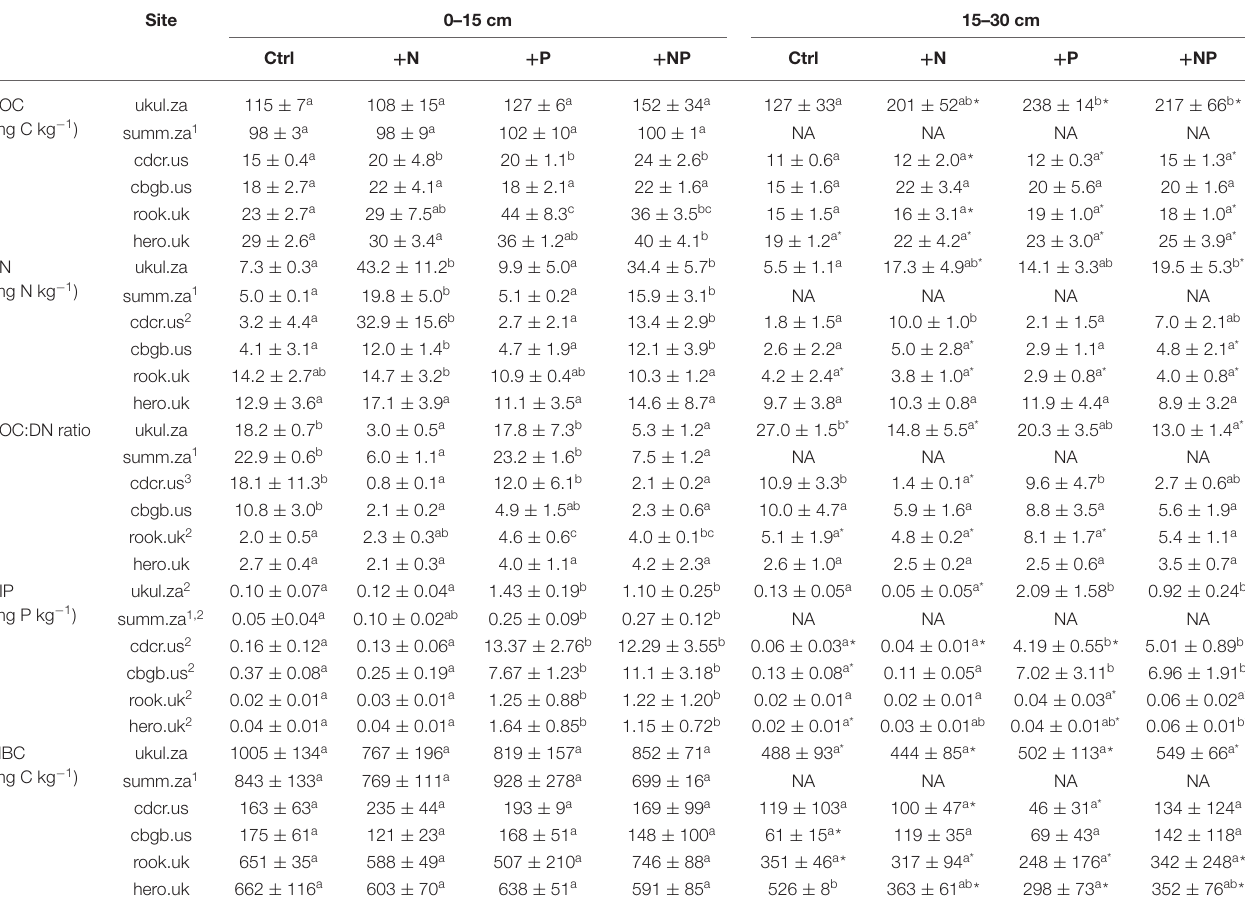
TABLE 3 | Dissolved organic carbon (DOC), dissolved nitrogen (DN), dissolved inorganic phosphorus (DIP), and microbial biomass carbon (MBC) in 0-15 and 15–30cm depth in the sampled soils.